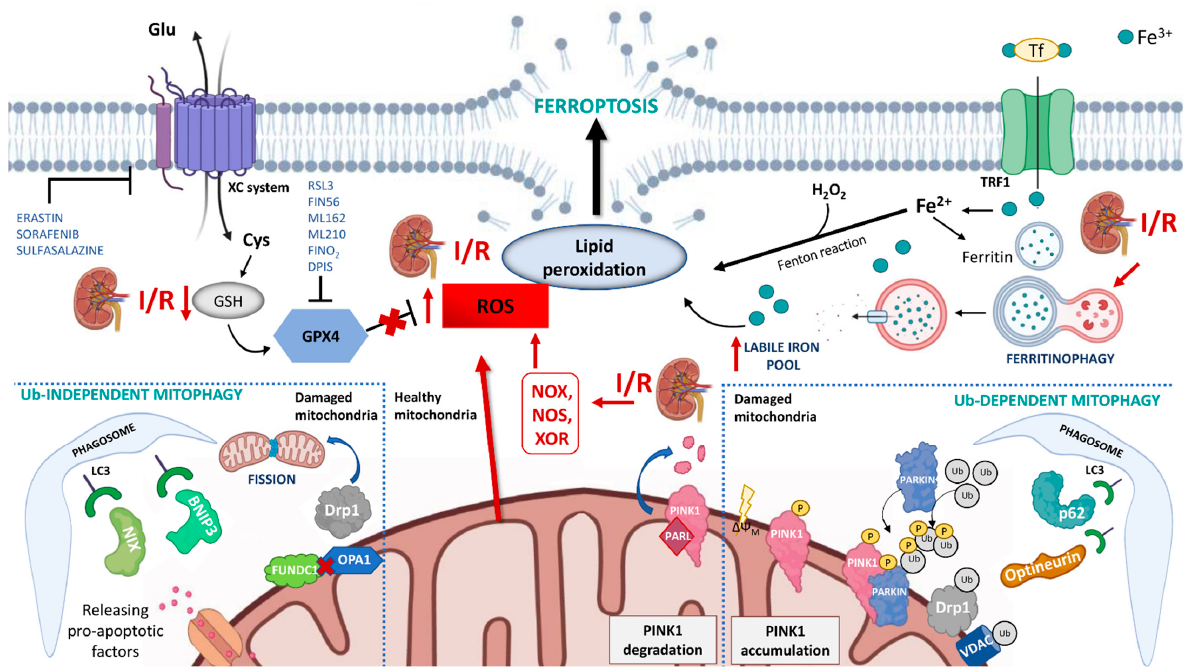
Figure 1. Schematic representation of the mechanisms of ferroptosis and mitophagy in renal ischemia/reperfusion (I/R) injury. During I/R several pathways contribute to ferroptosis: (i) the overproduction of ROS by NADPH oxidase (NOX), nitric oxide synthase (NOS), xanthine oxidoreductase (XOR) and mitochondria promotes lipid peroxidation and plasmatic membrane rupture; (ii) the reduction in glutathione (GSH) content inhibits glutathione peroxidase 4 (GPX4) activity and its protective action against membrane lipid peroxidation; (iii) I/R can indirectly induce ferritinophagy which causes the degradation of intracellular ferritin, and the increment of intracellular labile iron pool. Mitophagy is activated in I/R through both ubiquitin-dependent and ubiquitin-independent mechanisms and seems to have a protective role in I/R injury by reducing the release of reactive oxygen species from dysfunctional mitochondria. In physiological conditions, PINK1 is imported into mitochondria where it is cleaved by the intramembrane serine protease presenilin associated rhomboid-like (PARL) and ultimately degraded. When mitochondria are damaged, and lose their membrane potential, PINK1 accumulates on the mitochondrial outer membrane (MOM) and recruits Parkin. Parkin ubiquitinates several mitochondrial substrates such as voltage-dependent anion-selective channel protein (VDAC) and dynamin-1-like protein (DRP1). These ubiquitinated proteins can recruit mitophagy receptors (such as optineurin, p62) that link mitochondria to autophagosomes through interacting with LC3. This causes an autophagic engulfment of the organelle necessary for its degradation. The ubiquitin-independent mechanism is regulated by mitophagy re- ceptors that localize on MOM, such as BCL2 interacting protein 3 (BNIP3), BNIP3-like (BNIP3L/NIX), and FUN14 domain containing 1 (FUNDC1). These proteins bridge mitochondria to autophagosome by directly interacting with